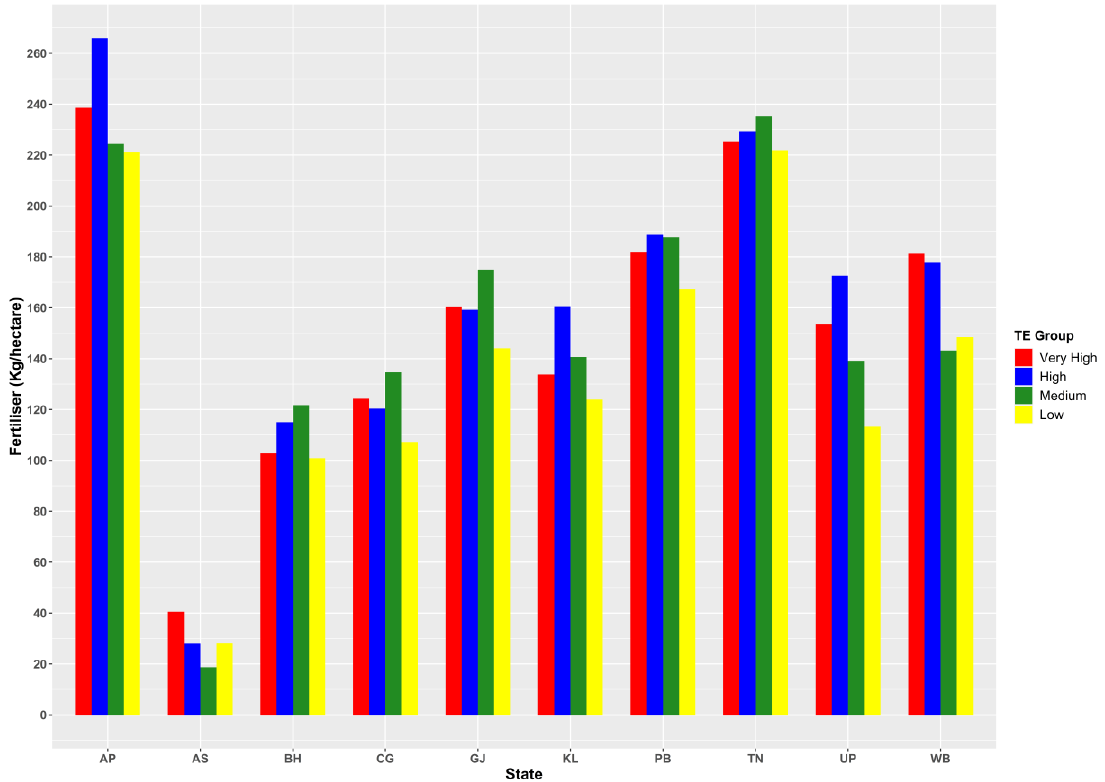
Figure 7. Fertilizer use in paddy (kg/hectare) across various states and efficiency